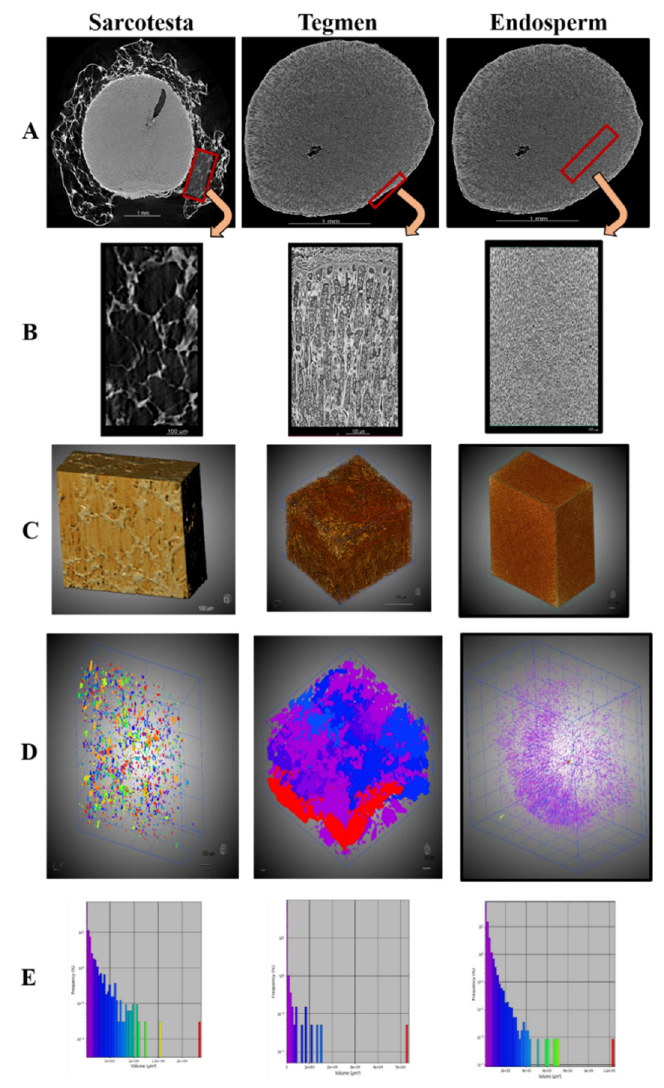
Figure 5. Detailed segmentation of pores in sarcotesta, tegmen, and endosperm; ( A ) Virtual image stack, ( B ) Demarcation, ( C ) Segmented 3D image, ( D ) Visualization of pores, ( E ) Color-coded pore volume distribution histogram; Colour scale- large (red) to small (purple).